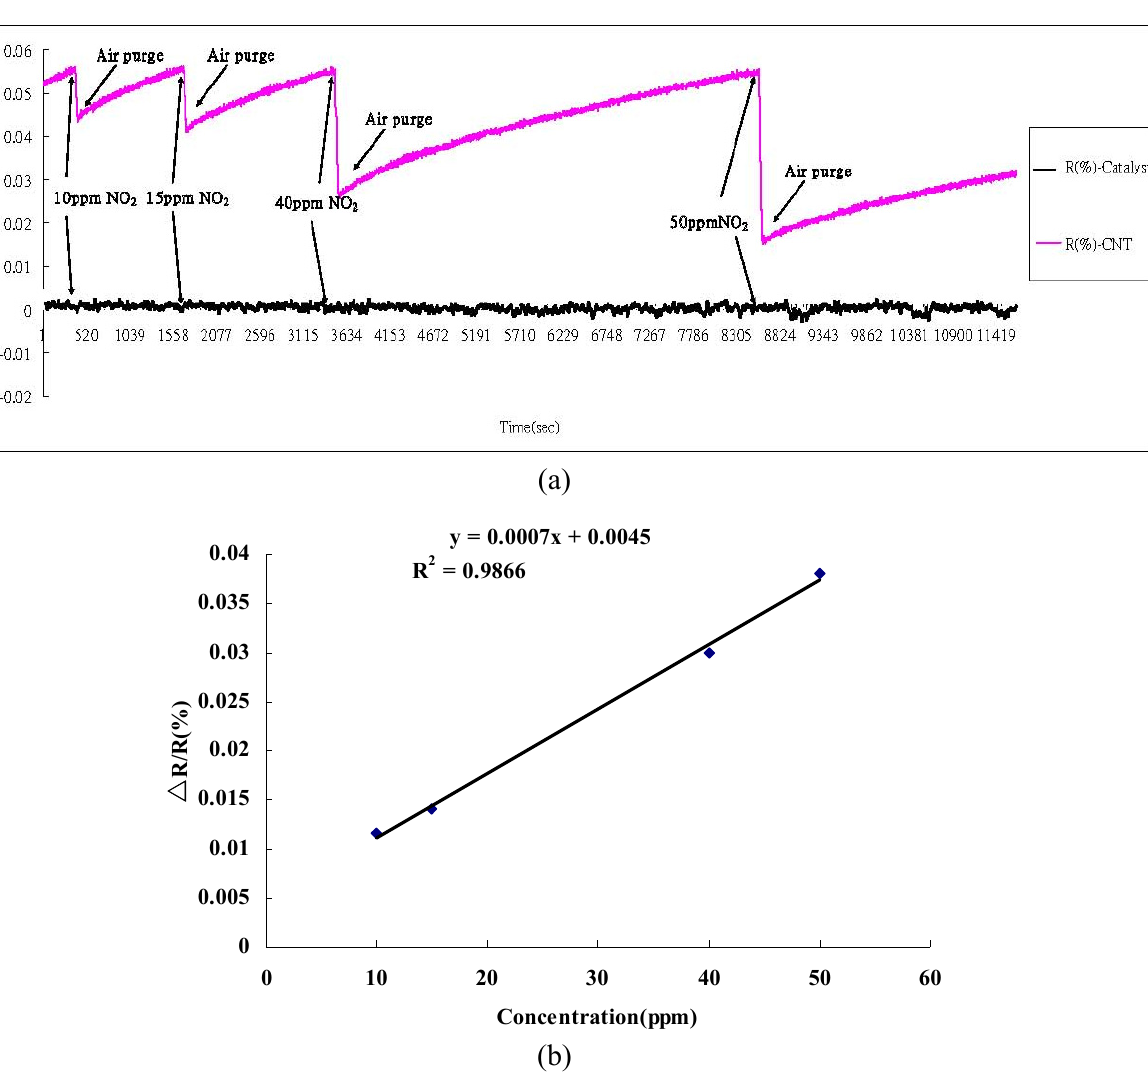
Figure 6. ( a ) The gas sensing devices with SWCNT network s (initial resistances: 44.343 k Ω ) and with only Fe catalyst on substrate responding to the NO gas of 10, 15, 40, and 50 ppm 2 at room temperature, with a gate voltage set at zero, exhibited an increase in response R/R △ (%) upon exposure to NO ; ( b ) The calibration curve was derived from Figure 6(a). 2